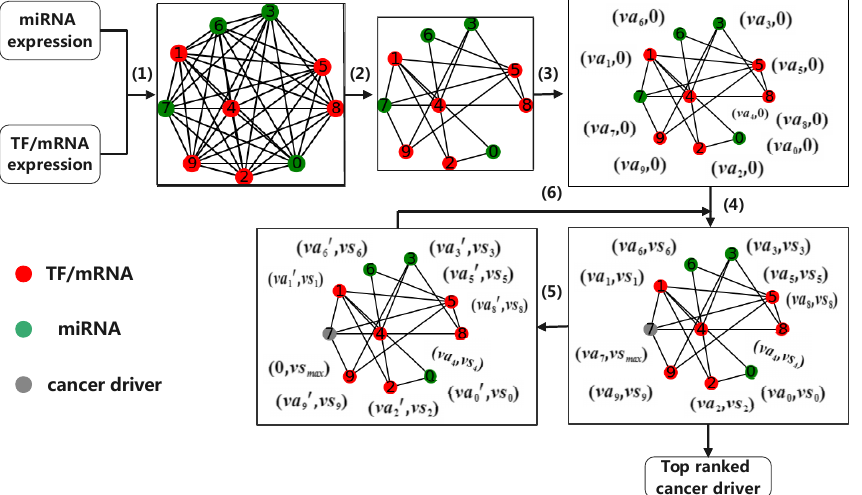
Figure 1. An illustration of identifying cancer driver. (1) Calculating Pearson’s correlation coefficient between genes; (2) Refining network; (3) Initializing voting ability; (4) Voting according to voting mechanism; (5) Updating voting ability; and (6) Repeating step